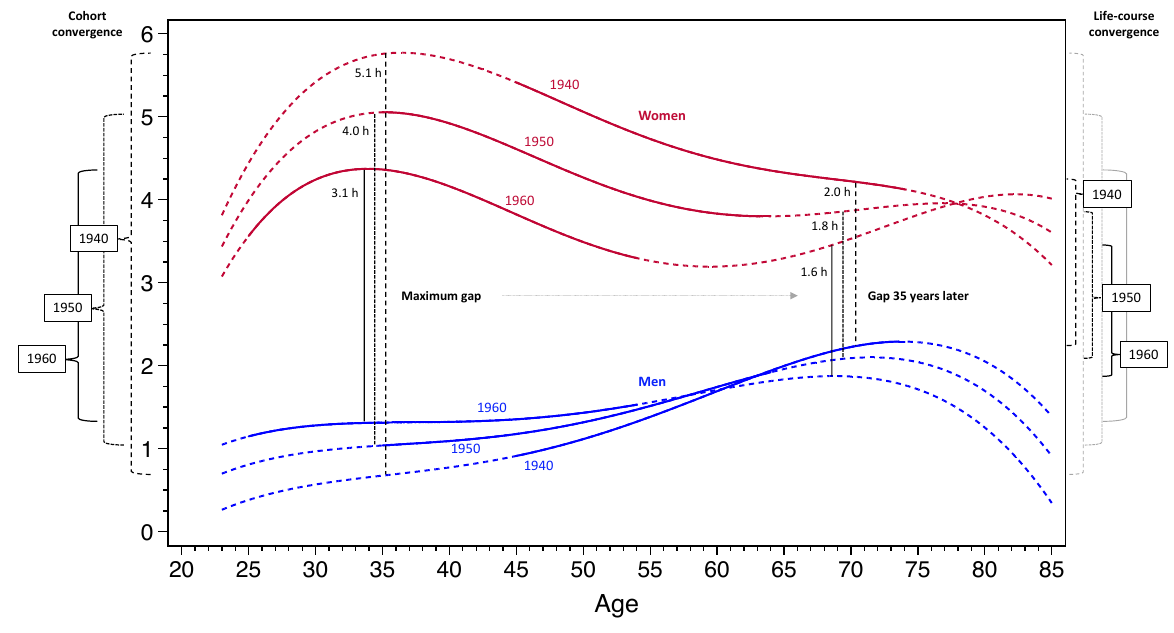
Figure 2: Life-course projections of housework time for three cohorts of women and men. Notes: SOEP version 32.1 (1985–2015), release 2017. Red curves are women, blue curves are men. Dashed lines are sample extrapolations. Mean values of housework time are shown for every age and separately by cohorts collapsed into 10-yearly intervals. h,